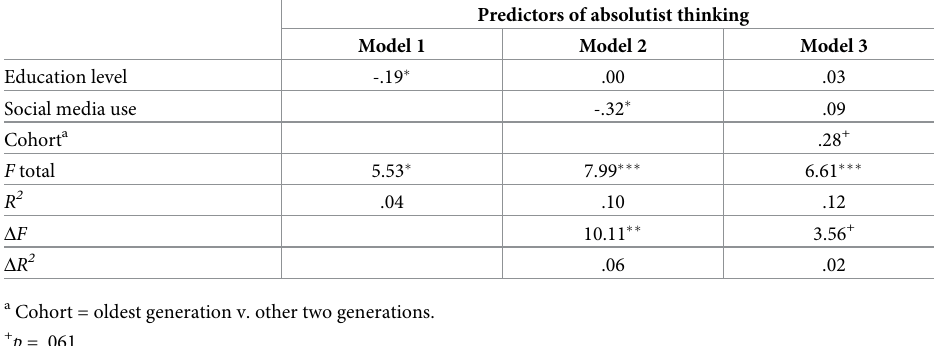
Table 3. Hierarchical regression: Predictors of absolutist thinking.